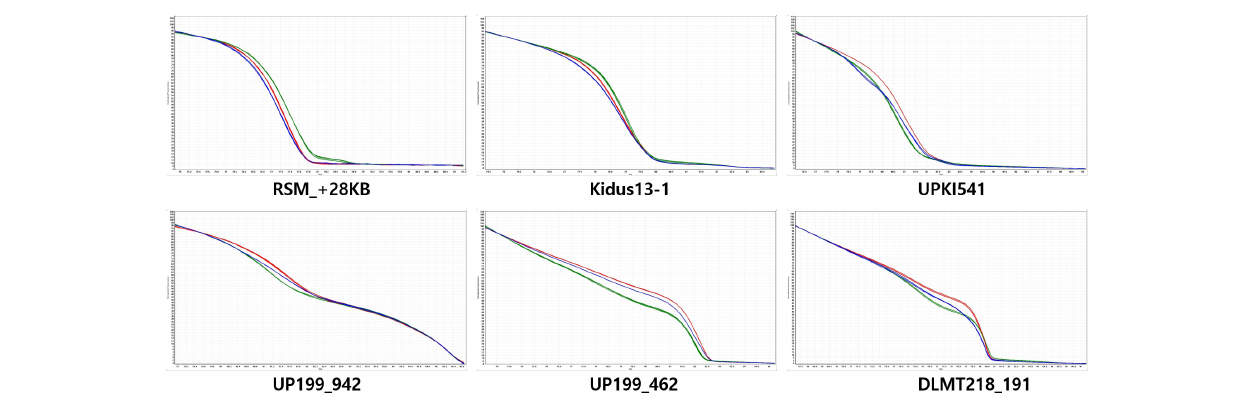
FIGURE 3 | Normalized codominant high-resolution melting (HRM) curves for fruit orientation in the LA F 2 population. The y -axis shows temperature and the x -axis shows normalized fluorescence. Six HRM markers are codominant predictors of the genotype of the dominant pendent (green), recessive erect (red), and